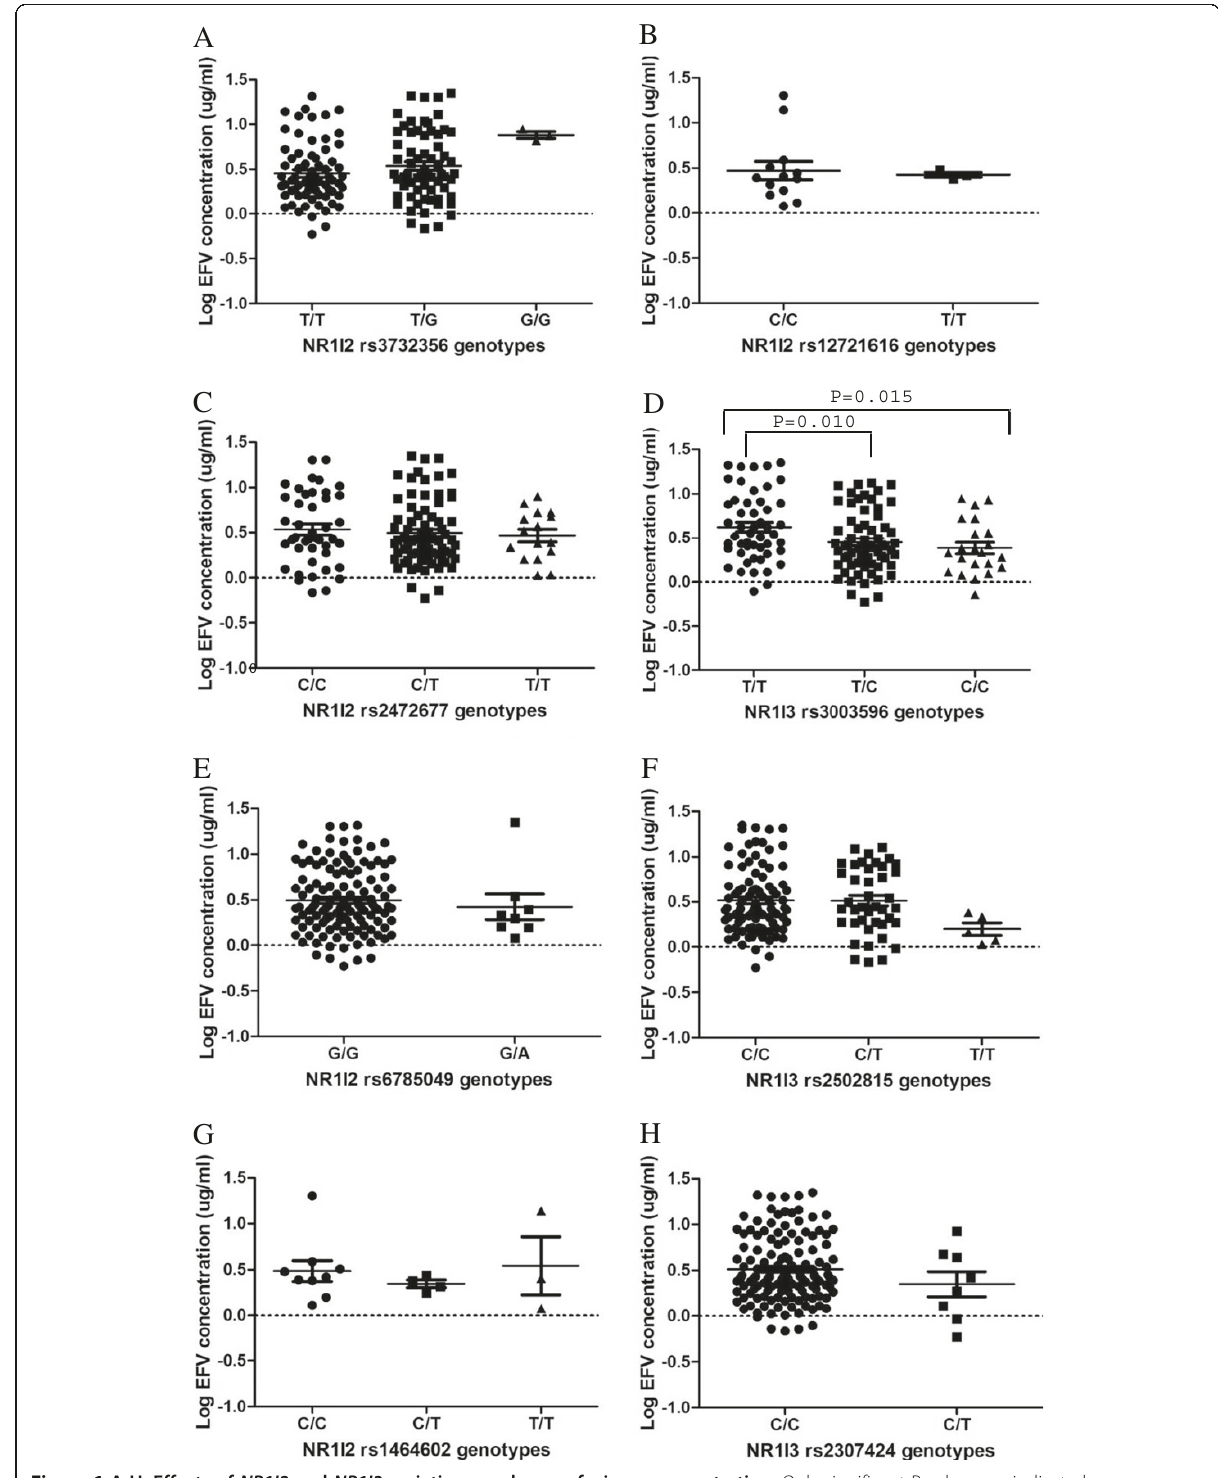
Figure 1 A-H: Effects of NR1I2 and NR1I3 variation on plasma efavirenz concentration. Only significant P-values are